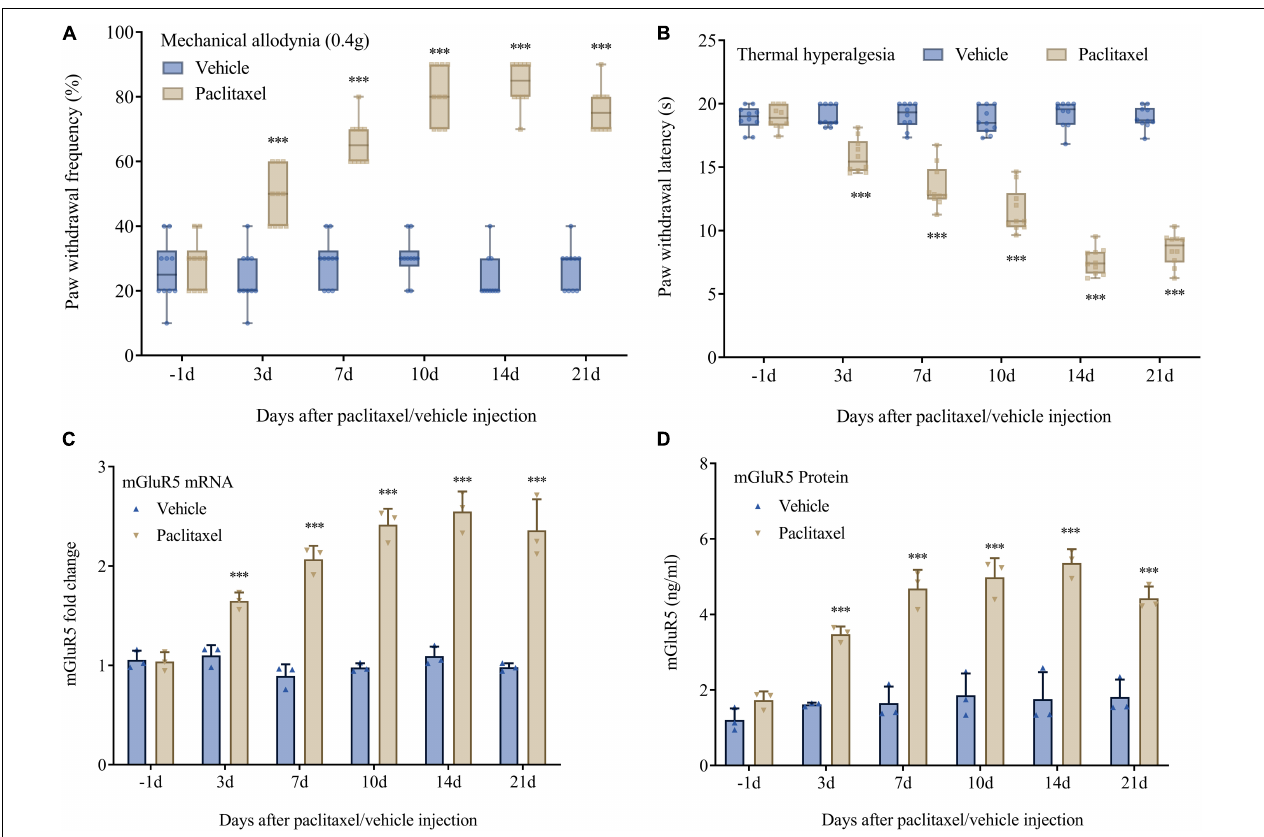
FIGURE 1 | Paclitaxel-induced neuropathic pain is accompanied by upregulated DRG mGluR5 in mice. (A) Mechanical allodynia development as assessed by paw withdrawal frequency in the von Frey test. (B) Thermal pain development as assessed by paw withdrawal latency in the heat sensitivity test. DRG L3-5 segments were obtained for biochemical assays. (C) mGluR5 mRNA levels were determined as fold elevation vs. baseline values, with GAPDH utilized for normalization. (D) ELISA detection of mGluR5 levels after paclitaxel injection. Data are median with interquartile ranges, and individual data points are shown ( n = 10). *** P < 0.001 vs. Vehicle group at the same time